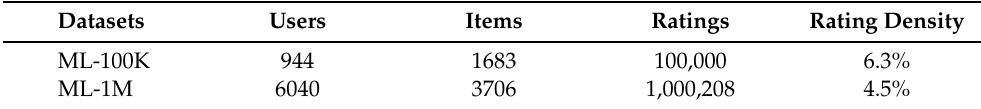
Table 1. Details of the datasets used. Datasets Users